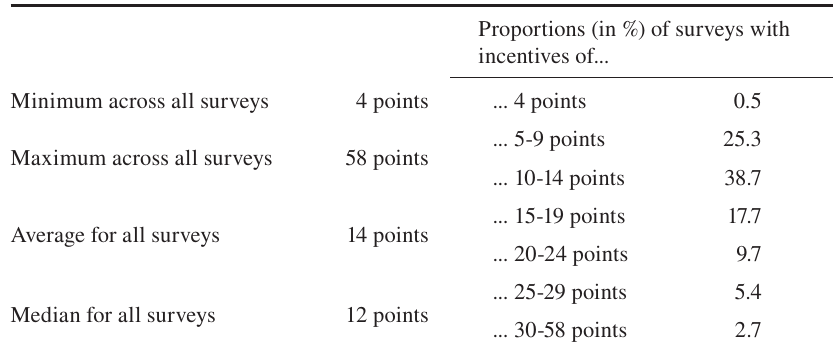
Table 7 Incentives received (in number of points)